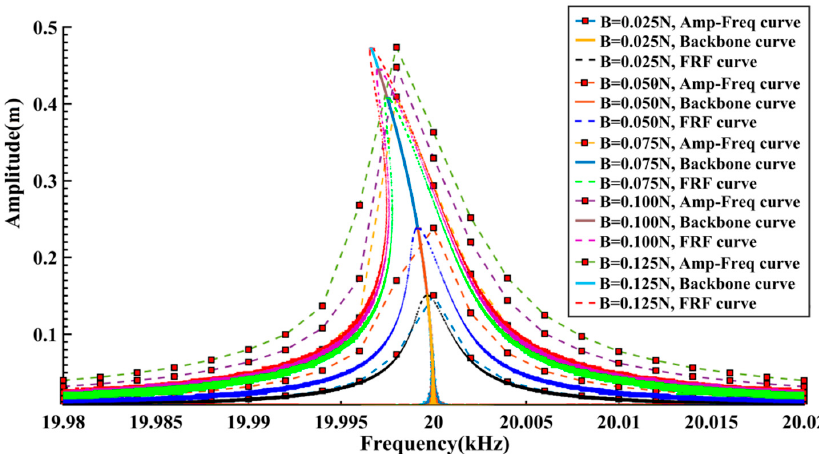
Figure 6. Comparison of the simulation results.